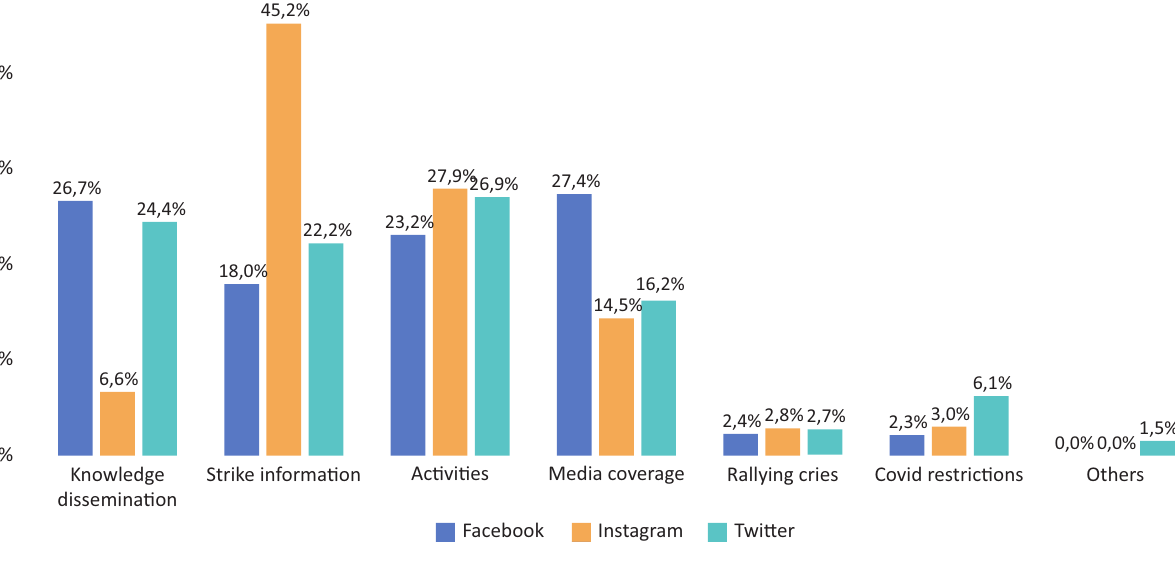
Figure 1. Topics of posts published on social media by 8M committees (March 2019 and March 2021).